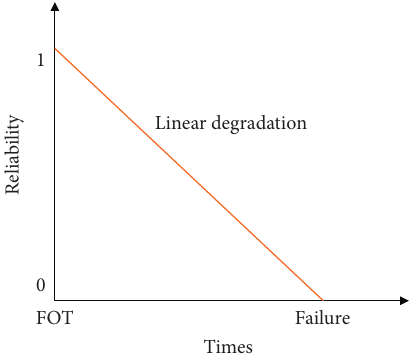
Figure 6: The label of the training